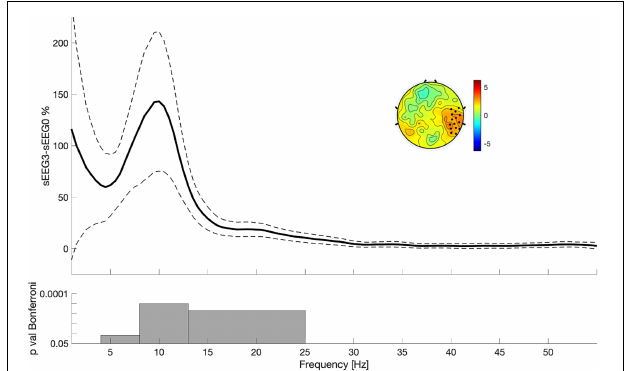
FIGURE 3 | Power differences between sEEG3 and sEEG0 considering the electrodes highlighted in the topography. Lines indicate mean across all subjects (filled lines) and standard error of the mean (dotted lines). The topography is the result of the comparison between sEEG3 and sEEG0 in the entire spectrum (1–55 Hz). Black dots highlighted significant clusters of electrodes ( p < 0.05, non-parametric cluster-based permutation testing). Bottom: results of the Paired t -tests with Bonferroni